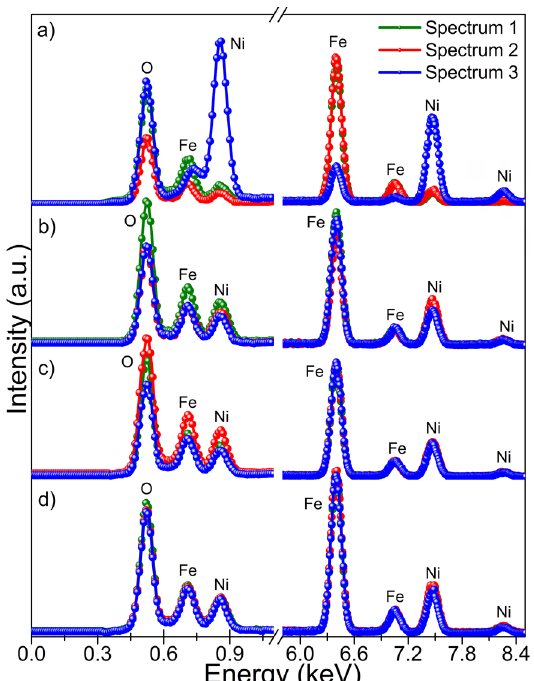
Figure 8. EDS spectra of (a) the initial mixture of reactants and of the samples submitted to heat treatments at (b) 1000 ºC, (c) 1100 ºC and (d) 1200 ºC. For each sample, the three spectral components are related to the randomly selected zones in the SEM